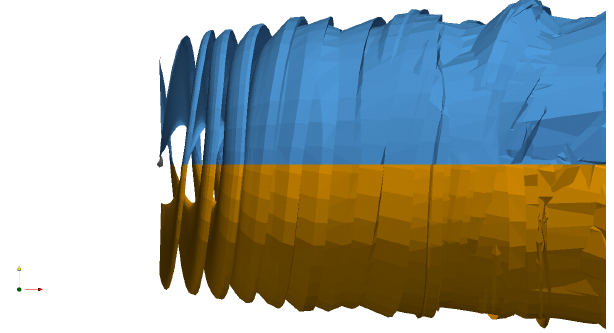
Figure 29. Wake for real (top, blue) and pseudo (bottom, orange) yaw motion at f =